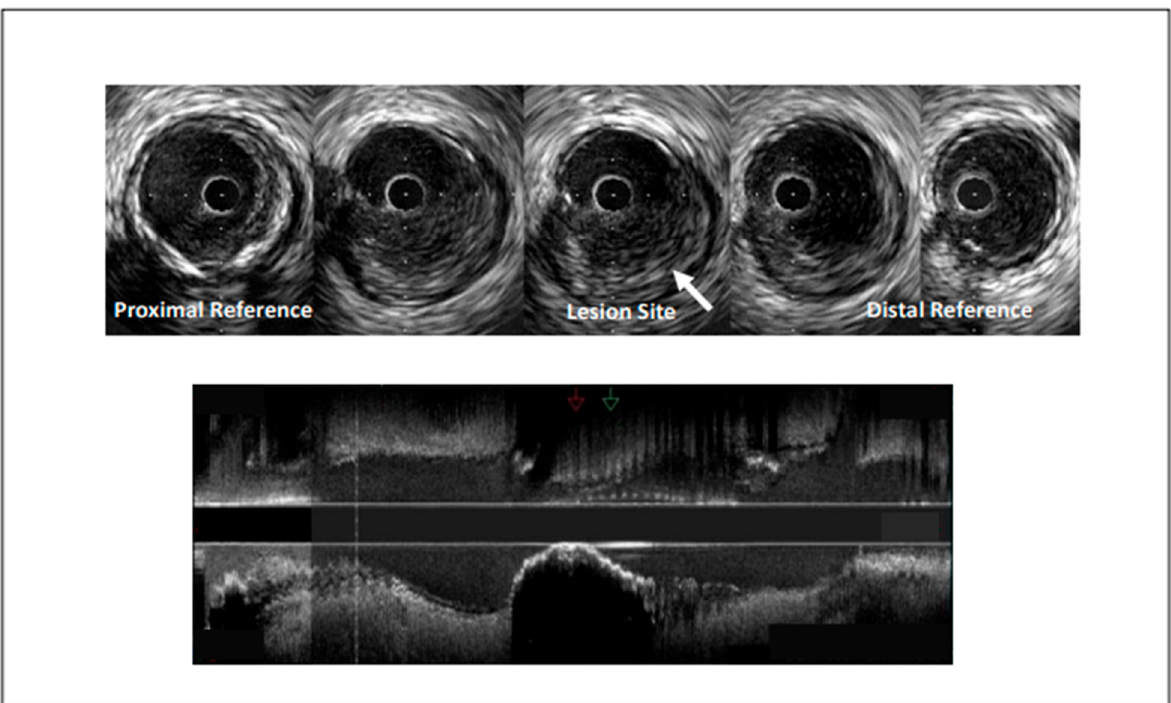
Figure 1. Intravascular ultrasound demonstrating coronary artery stenosis most likely due to plaque erosion.